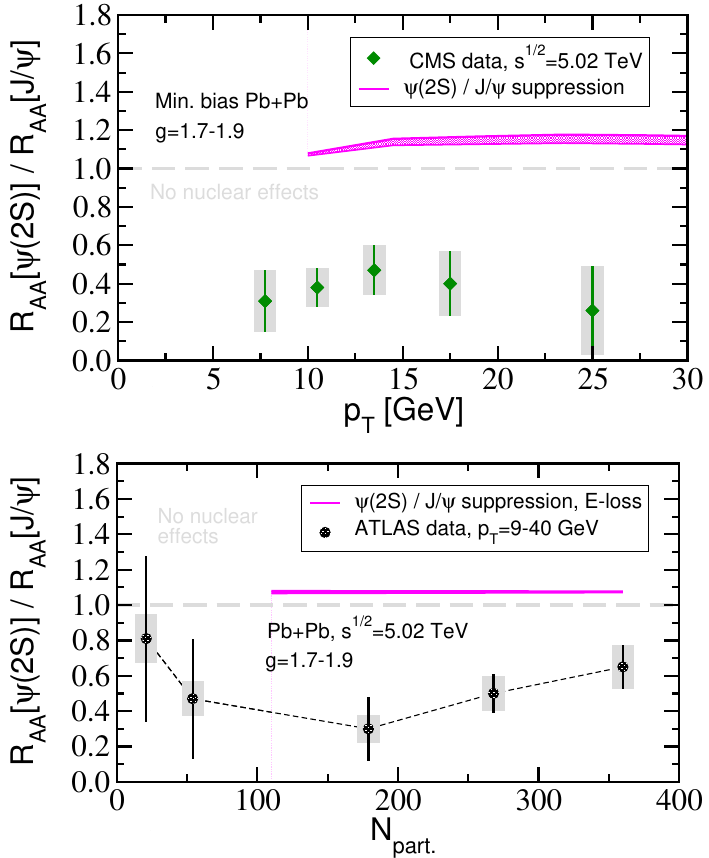
Figure 4 . The double ratio of (2 S ) to J= suppression (purple bands) as a measure of the relative signi(cid:12)cance of QCD matter e(cid:11)ects on ground and excited states is compared to energy loss model calculations. Upper panel: comparison between theory and CMS data [43] as a function of transverse momentum p T for minimum bias collisions. Lower panel: comparison between theory and ATLAS data [44] as a function of centrality integrated in the p T region of 9{40 GeV. the energy loss approach combined with leading power factorization is not compatible with existing experimental data from the LHC. The tensions are both in the overall magnitude of J= suppression and in the relative suppression of the (2 S ) to the ground J= .